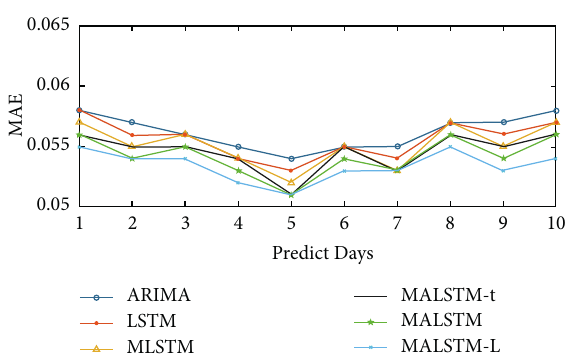
Figure 7: Experimental results of